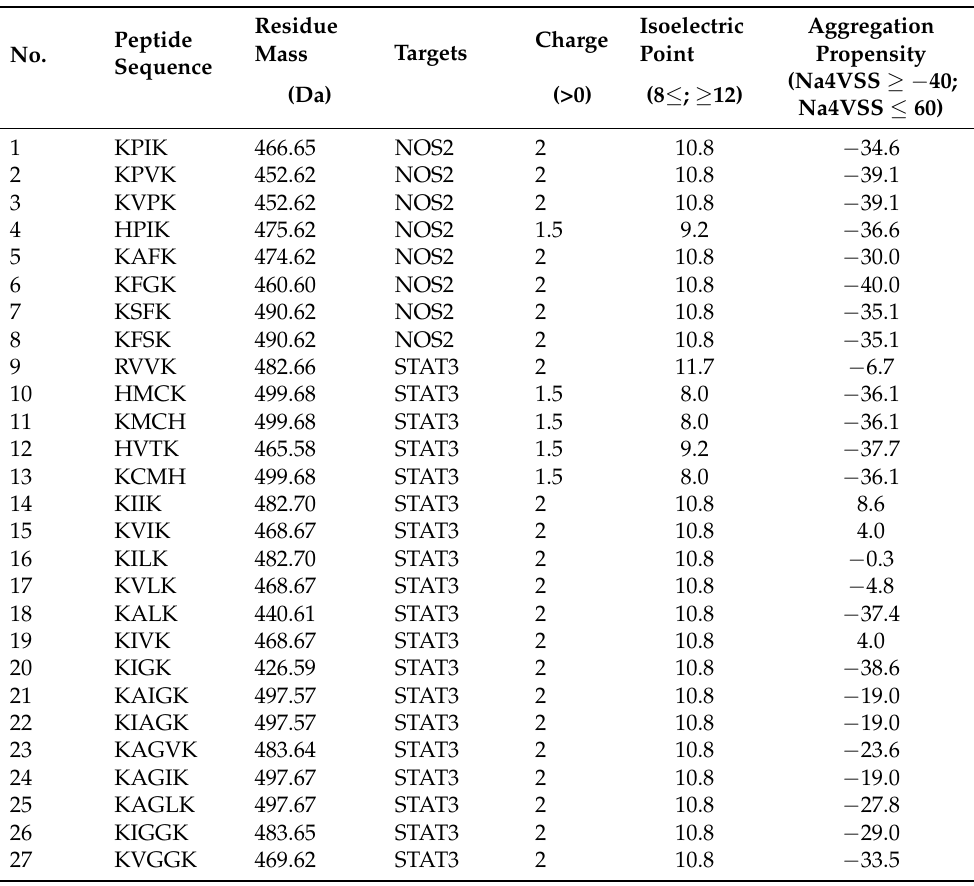
Table 5. The physicochemical properties of the final 27 peptides on AMPs—AFPs—ACPs’ axis.